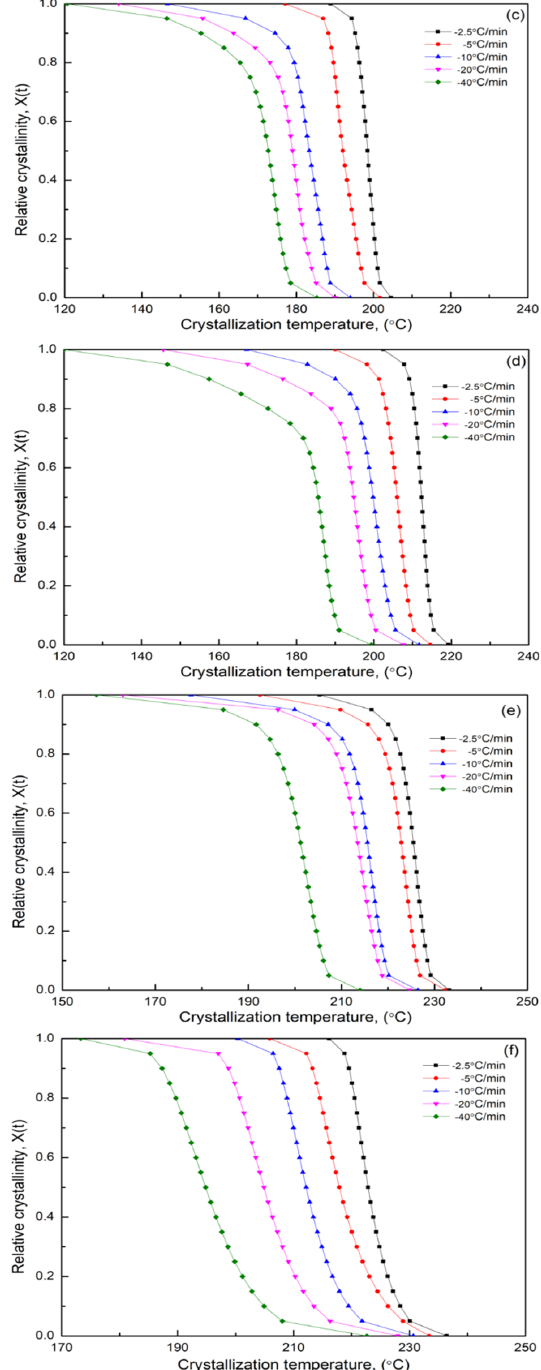
Figure 10. Relative crystallinity X ( t ) at different crystallization temperatures T in the process of nonisothermal crystallization of ( a ) PA56, ( b ) CoPA ‐ 2, ( c ) CoPA ‐ 3, ( d ) CoPA ‐ 4, ( e ) CoPA ‐ 5 and ( f ) PA66.